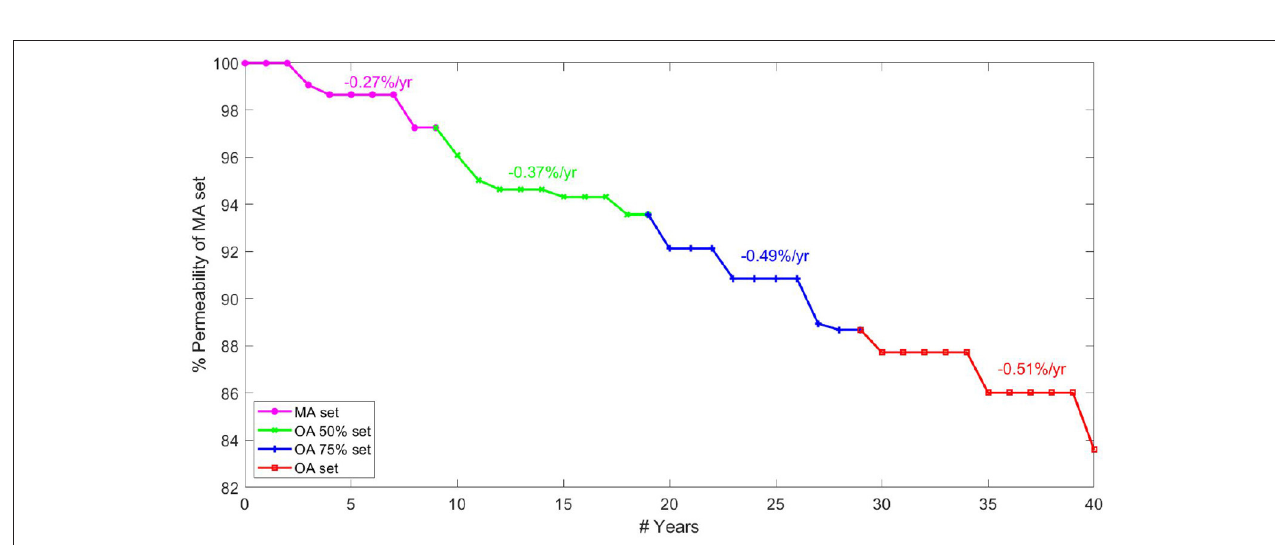
FIGURE 7 | Distributions of capillary volume fraction (left) and surface-area-to-volume ratio of the capillaries (right) in young (top) , middle aged (middle) , and old (bottom) capillary networks.